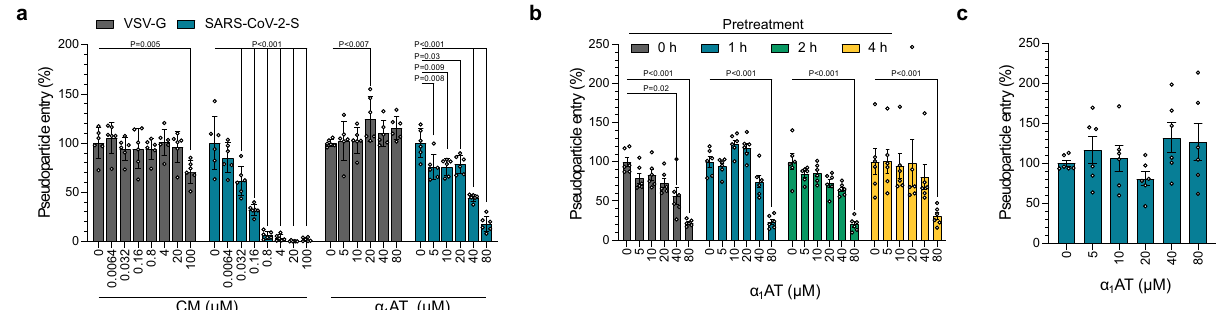
Fig. 2 α 1 AT inhibits SARS-CoV-2 spike but not VSV-G mediated pseudovirus entry. a Prolastin ( α 1 AT) and the control small molecule inhibitor camostat mesylate (CM) were added to Caco2 cells 1 h prior to transduction of cells with rhabdoviral SARS-CoV-2 spike (blue) or VSV-G pseudoparticles (gray). b Caco2 cells were treated for the indicated hours with Prolastin ( α 1 AT) and were then transduced with rhabdoviral SARS-CoV-2 spike pseudoparticles. c Prolastin ( α 1 AT) was added 2 h post transduction of Caco2 cells with rhabdoviral SARS-CoV-2 spike pseudoparticles. Transduction rates in a – c were determined at 16 h after addition of pseudoparticles by measuring luciferase activities in cell lysates. The mean ± SEM from n = 2 experiments in biological triplicates are shown (2-way ANOVA with Dunett´s multiple comparison test). Source data are provided as a Source data